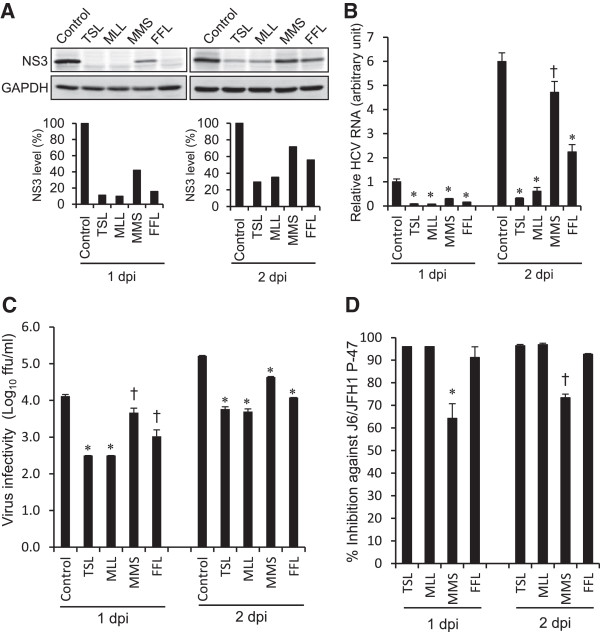
Inhibition of HCV protein expression, HCV RNA replication and infectious virus production by ethanol extracts of TSL, MLL, MMS and FFL. (A) Huh 7.5 cells infected with HCV J6/JFH1-P47 and treated with the extracts (30 μg/ml) of TSL, MLL, MMS and FFL (see Figure 1A) and the untreated control were subjected to Western blot analysis using monoclonal antibody against the HCV NS3 protein at 1 and 2 days post-infection (dpi). GAPDH served as an internal control to verify equal amounts of sample loading. Signal intensities of NS3 were normalized to the corresponding GAPDH signal. (B) Amounts of HCV RNA in the cells described in (A) were measured by real-time quantitative RT-PCR analysis. The HCV RNA amounts were normalized to GAPDH mRNA expression levels. Data represent means ± SEM of data from two independent experiments, and the value for the untreated control at 1 dpi was arbitrarily expressed as 1.0. *, P < 0.000001; ǂ, P < 0.001, compared with the control. (C) Virus infectivity in the culture supernatants of the cells described in (A) was measured. Data represent means ± SEM of data from two independent experiments. ǂ, P <0.05; *, P < 0.005, compared with the control. (D) Inhibition of HCV infectivity by the extracts (30 μg/ml) of TSL, MLL, MMS and FFL are shown. *, P < 0.05; ǂ, P < 0.01, compared with TSL.